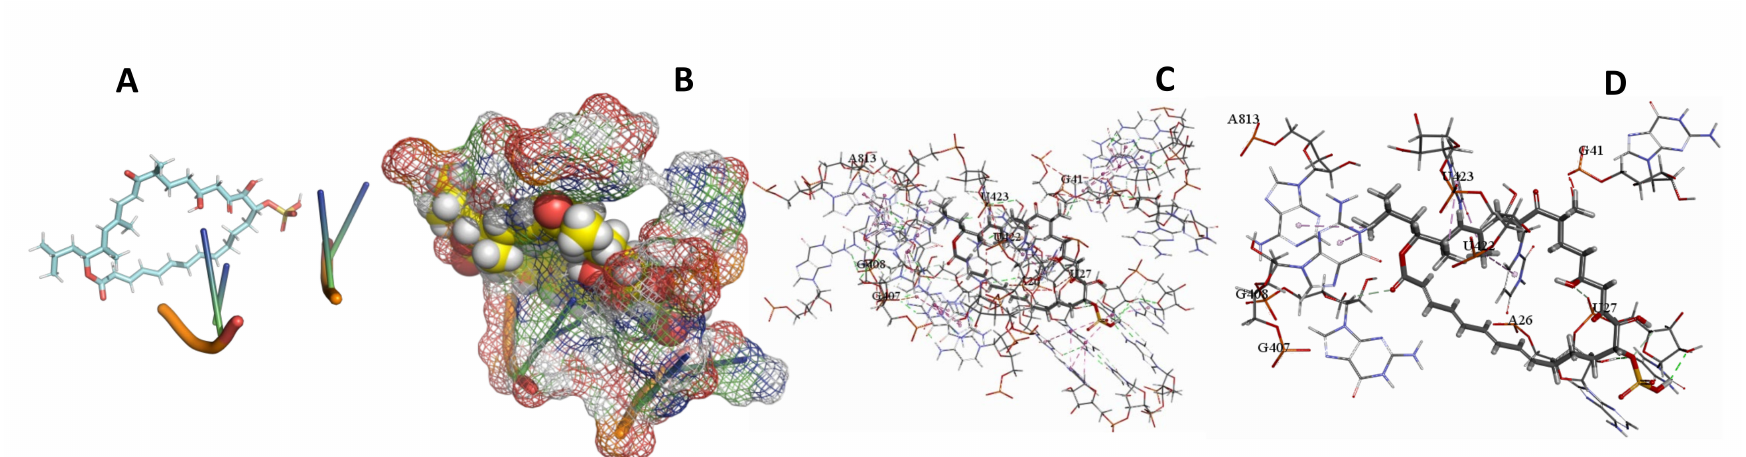
Figure 31. L. Major + Sulfangolid A. ( A ): Best binding pose and nucleotides involved. ( B ): Schematic binding pocket. ( C ): shows the Nucleotides component that re involved in binding. ( D ): Shows the main bonds involved between the compound and the nucleotide